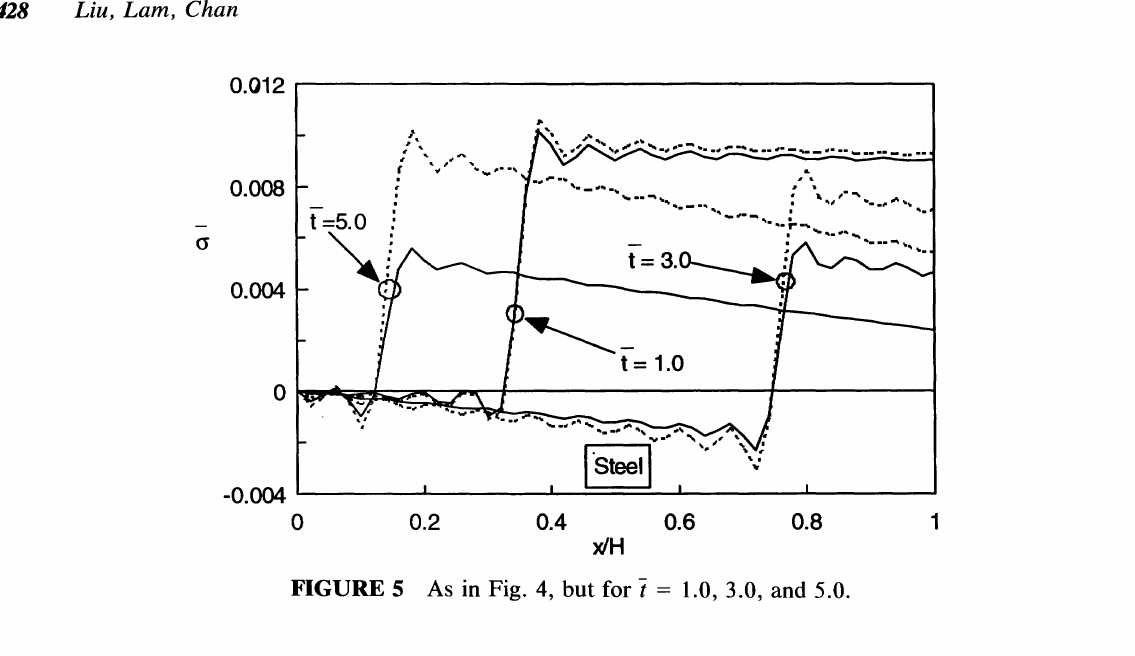
FIGURE 5 As in Fig. 4, but for t = 1.0, 3.0, and 5.0.